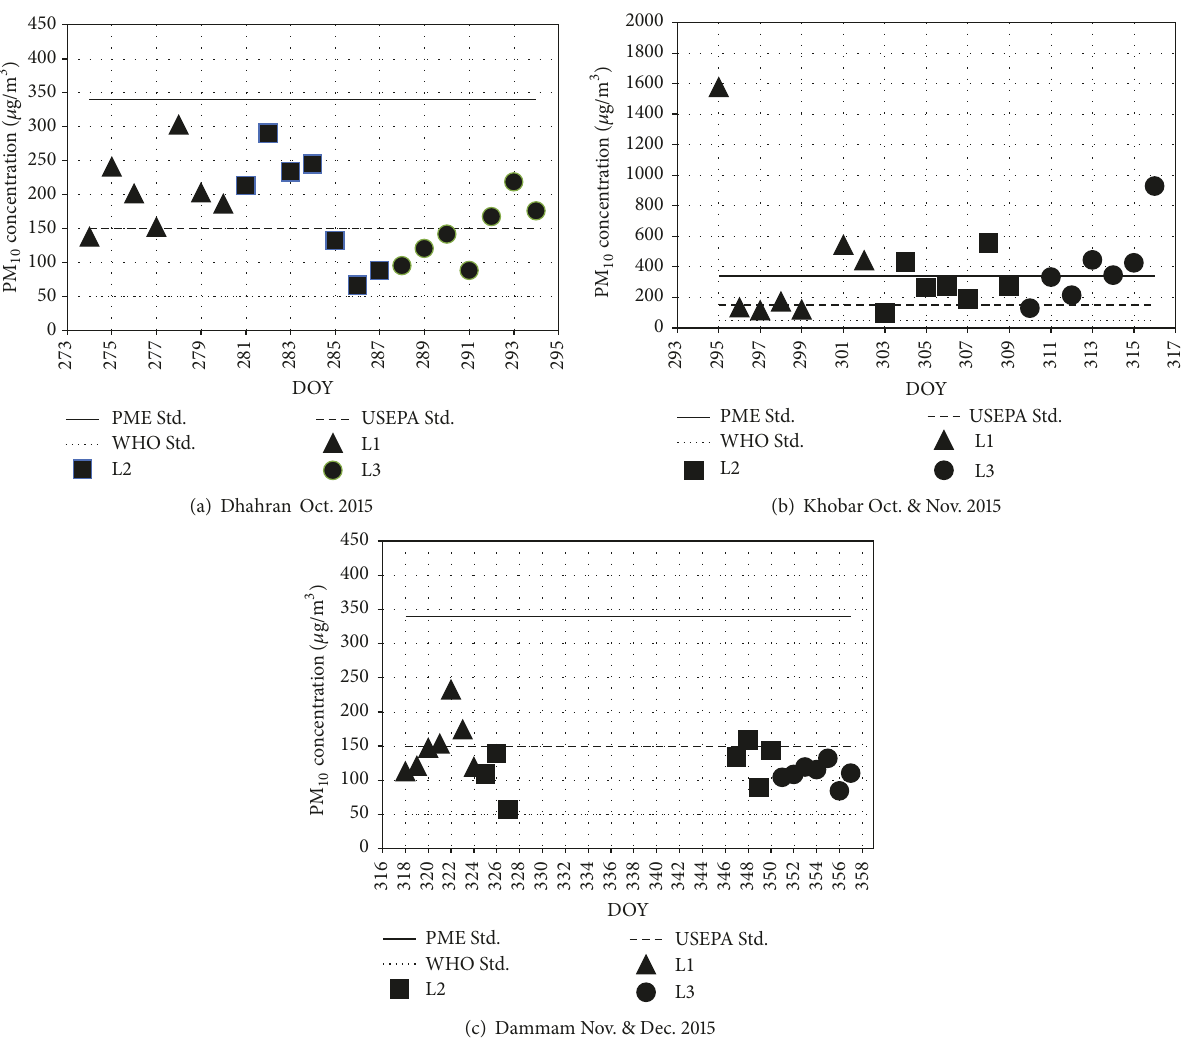
Figure 3: (a) PM 10 concentration in Dhahran L1: Location 1, L2: Location 2, and L3: Location 3, DOY: day of the year, (b) PM 10 concentration in Khobar L1: Location 1, L2: Location 2, and L3: Location 3, and (c) PM 10 concentration in Dammam L1: Location 1, L2: Location 2, and L3: Location